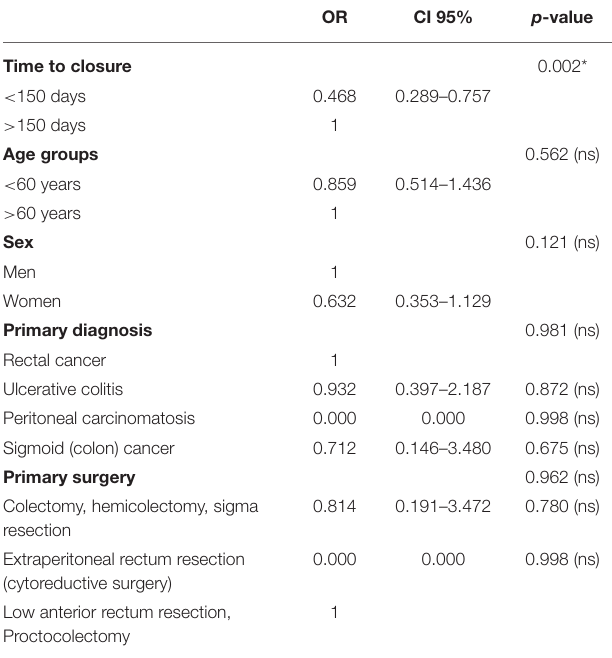
TABLE 4 | Multivariate analysis of risk factors in complications after closure of the protective loop-ileostomy. OR CI 95% p